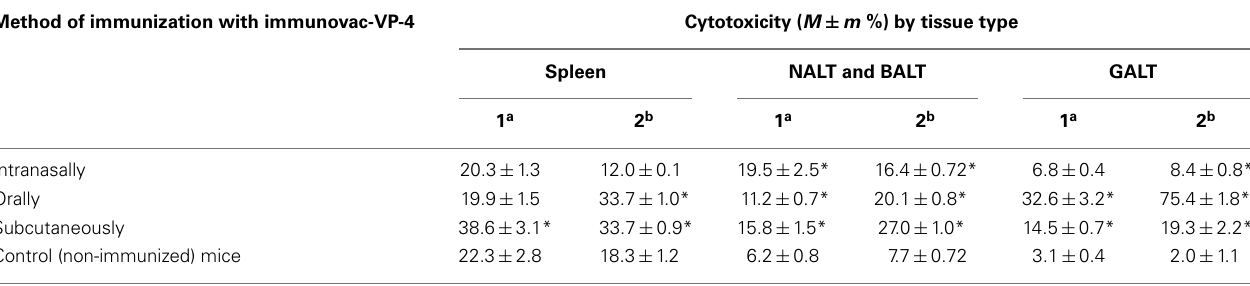
Table 2 | Cytotoxic activity of mononuclear leukocytes against NK-dependent tumor cell line K562. Method of immunization with immunovac-VP-4